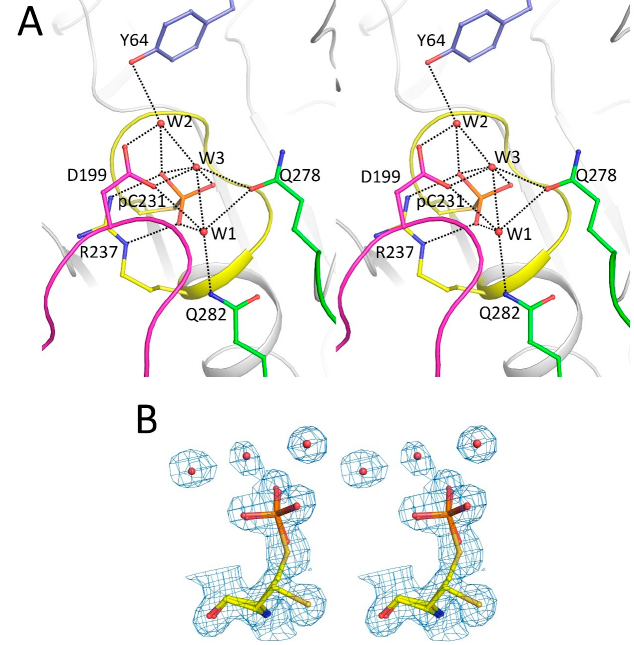
Figure 2. Catalytic site of PTPN12. ( A ) A stereoview showing the hydrogen-bonding interactions between water molecules and residues in the catalytic site. The coloring is the same as that used in Figure 1. Hydrogen bonds are indicated by dashed lines; ( B ) a representative composite-omit-map (1.0 contour level) of the catalytic Cys231 residue and surrounding water molecules. Figures were prepared using PyMOL (DeLano Scientific LLC, South San Francisco, CA, USA).